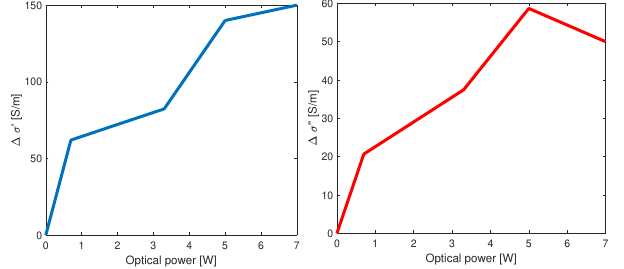
Figure 7. Extraction of the HR Si substrate photoconductance ∆ σ in (left) Real part and (right) imaginary part according to incident optical power P op at optical wavelength λ = 805 nm and microwave signal frequency F = 50